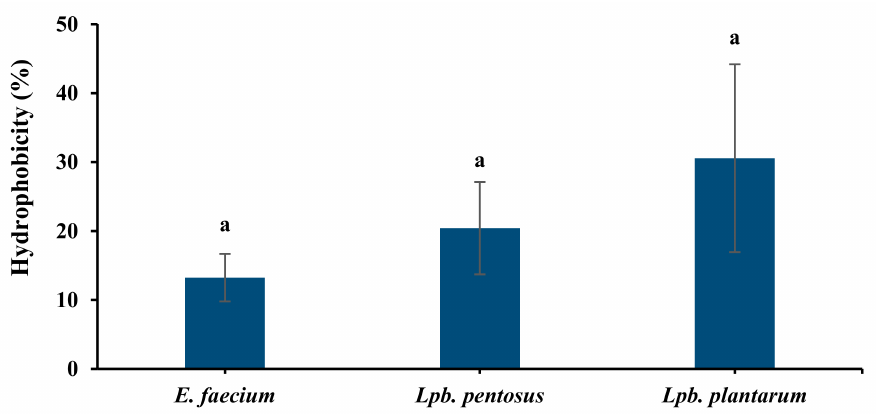
Figure 2. Cell surface hydrophobicity value of E. faecium , Lpb. plantarum , and Lpb. pentosus . There were no significant differences between the samples at p ≤ 0.05.